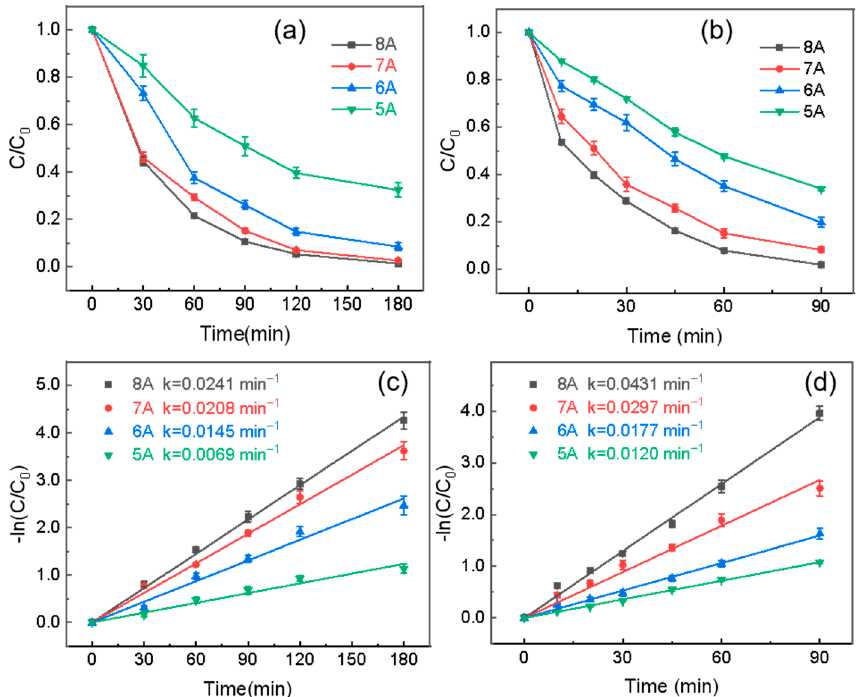
Figure 2. Effect of different currents on the photodegradation of ( a ) SMX and ( c ) ENR, and kinetic curves of ( b ) SMX and ( d ) ENR.